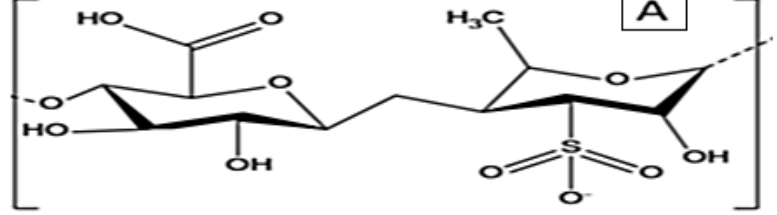
Figure 2. Ulvan chemical structure—A: glucuronic acid and rhamnose 3-sulfate.